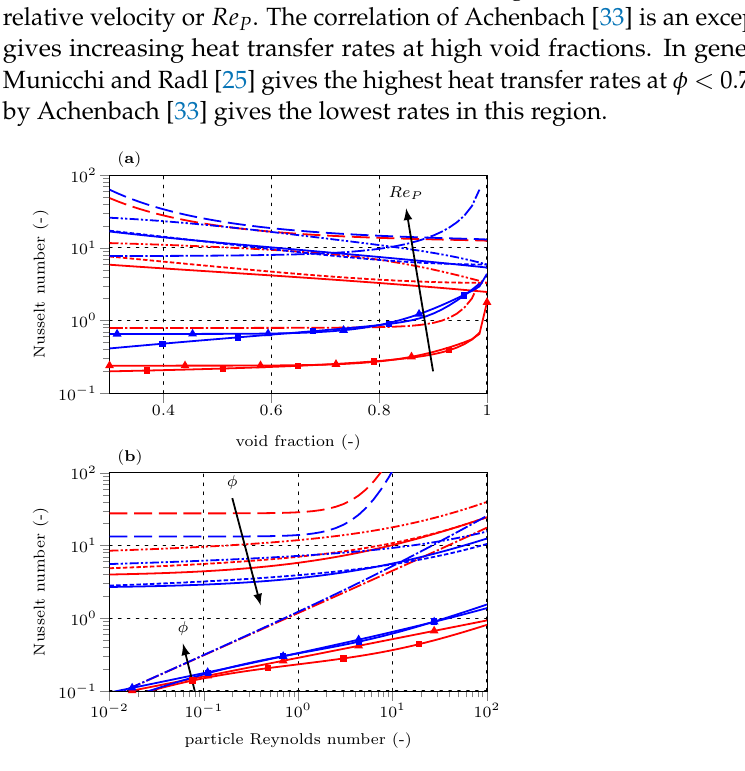
Figure 15. Comparison of various Nusselt number correlations from the literature (Achenbach [33] ( ), Gnielinski [32] ( ), Gunn [65] ( ), Sun et al. [24] ( ), Municchi and Radl [25] ( )) with the multiple linear regression (MLE) of Equation 16 ( ) and the Lévêque (GLE) of Equations (17)–(19) ( ) correlations versus void fraction ( a ) and particle Reynolds number ( b ). Red: ( a ) lower Re P , ( b ) lower void fraction; Blue: ( a ) higher Re P , ( b ) higher void